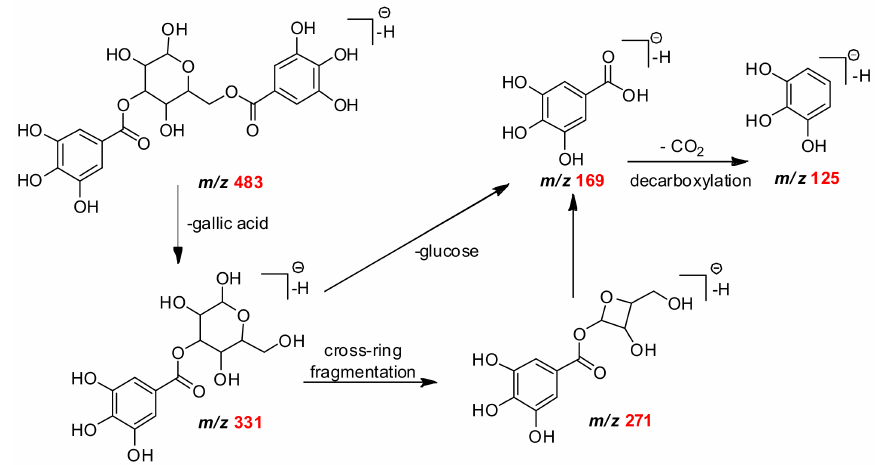
Scheme 1. The proposed fragmentation pathways of digalloyl-glucose isomer.